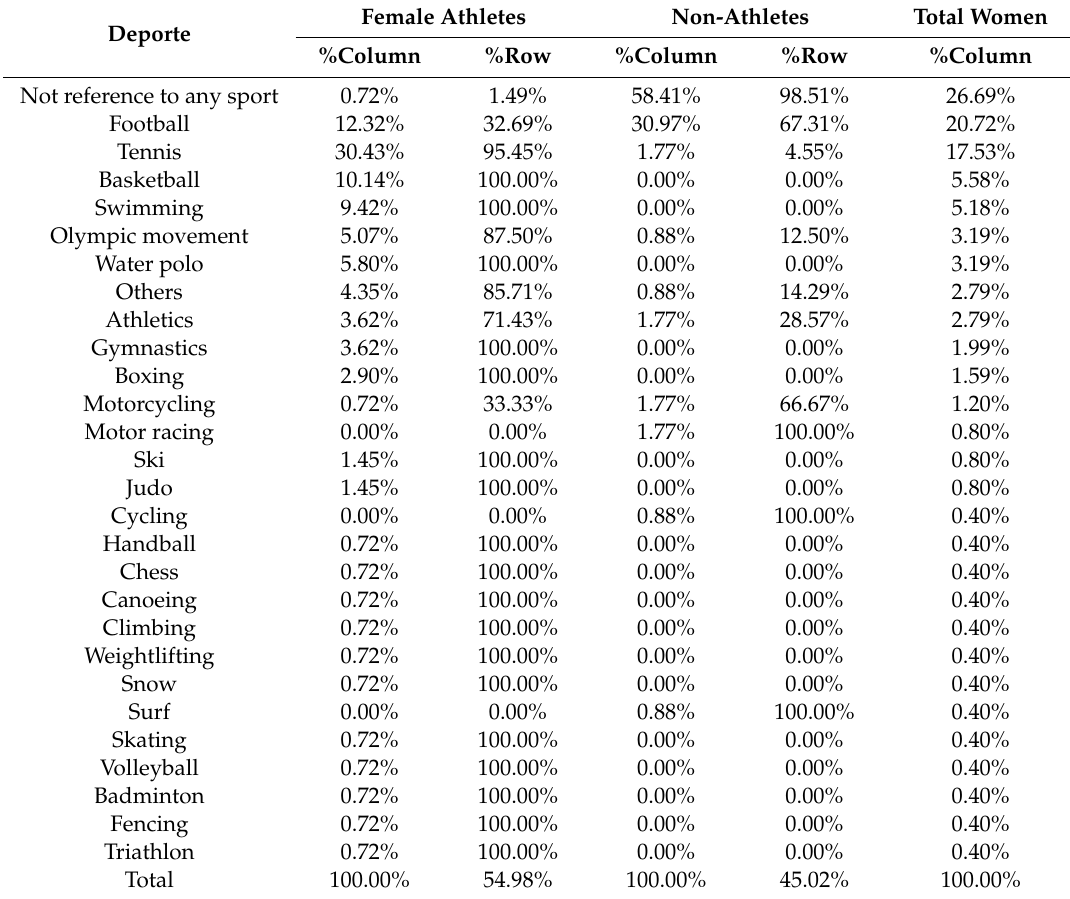
Table 10. Distribution of sample profiles of women represented (athlete vs non-athlete) according to the sport (n = 249). Female Athletes Non-Athletes Total Women Deporte %Column %Row Not reference to any